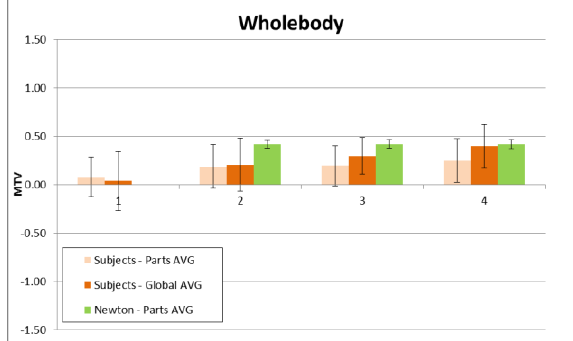
Fig. 2. Summer conditions evaluation of human subjects’ tests – Wholebody MTV for all subjects